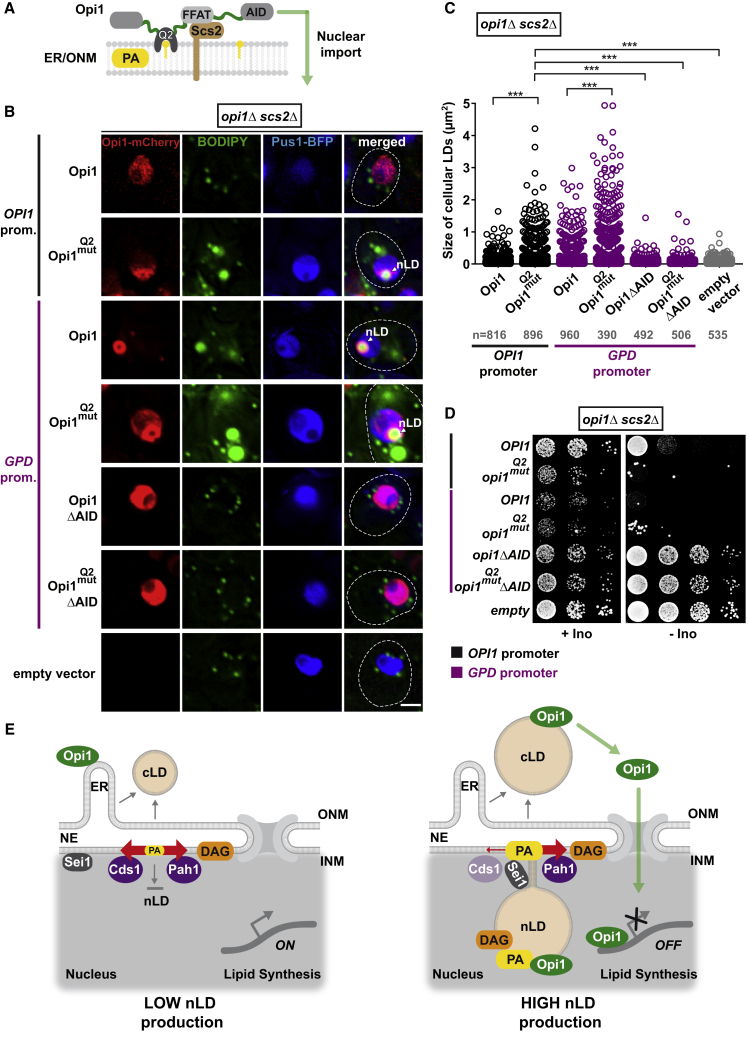
The Transcription Factor Opi1 Regulates Nuclear and Cytoplasmic Lipid Droplet Production(A) Cartoon of Opi1 domain organization and tethering to the endoplasmic reticulum (ER) and outer nuclear membrane (ONM) via its PA-sensing Q2 domain and the transmembrane protein Scs2. Opi1 contains an endogenous NLS, which partially overlaps with the Q2 domain (not depicted). FFAT, two phenylalanines (F) in an acidic tract motif; AID, activator interaction domain.(B) Live imaging of opi1Δ scs2Δ cells expressing the indicated plasmid-based Opi1-mCherry constructs or an empty vector. Lipid droplets were stained with BODIPY, the nucleoplasm with Pus1-BFP. Opi1 was either expressed from its endogenous promoter or overexpressed from the heterologous GPD (TDH3) promoter. Q2mut indicates a mutation in the PA-binding domain, which reduces but does not abolish PA binding. For expression levels, see Figure S7G. Scale bar, 2 μm.(C) Automated quantification of lipid droplet size in (B). n = number of analyzed cells. ∗∗∗p value <0.001 was determined by ANOVA with post hoc Tukey HSD.(D) Growth analysis of opi1Δ scs2Δ cells expressing different plasmid-based constructs of Opi1-mCherry as in (B). Growth was followed on SDC-Ura-His and SDC-Ura-His-Inositol (-Ino) plates for 2 days at 30°C. Note that several fast-growing suppressor colonies emerged in the opi1 Q2 mutant when expressed from the endogenous OPI1 promoter (lane 2, -Ino) or the stronger GPD promoter (lane 4, -Ino). These genetic suppressors rescue the growth defect by abolishing Opi1 expression; see Figures S7H and S7I.(E) Model of nLD synthesis. At times of low nLD synthesis, cLD formation may predominate. This situation is favored by low PA levels at the INM due to turnover into DAG by Pah1 and/or CDP-DAG (not depicted) by Cds1. Expression of enzymes involved in cellular lipid biosynthesis is high due to the tethering of Opi to the ER. In contrast, nLD formation is stimulated by Opi1 translocation into the nucleus and repression of target genes (lipid synthesis OFF), a state that also induces cLD production. PA levels at the INM are increased, and PA and DAG become enriched on INM-tethered nLDs. Cds1 inactivation is a putative switch to channel PA into the storage branch of lipid metabolism. Opi1 partitioning on cLDs and nLDs constitutes a negative feedback mechanism for lipid droplet production.See also Figure S7.